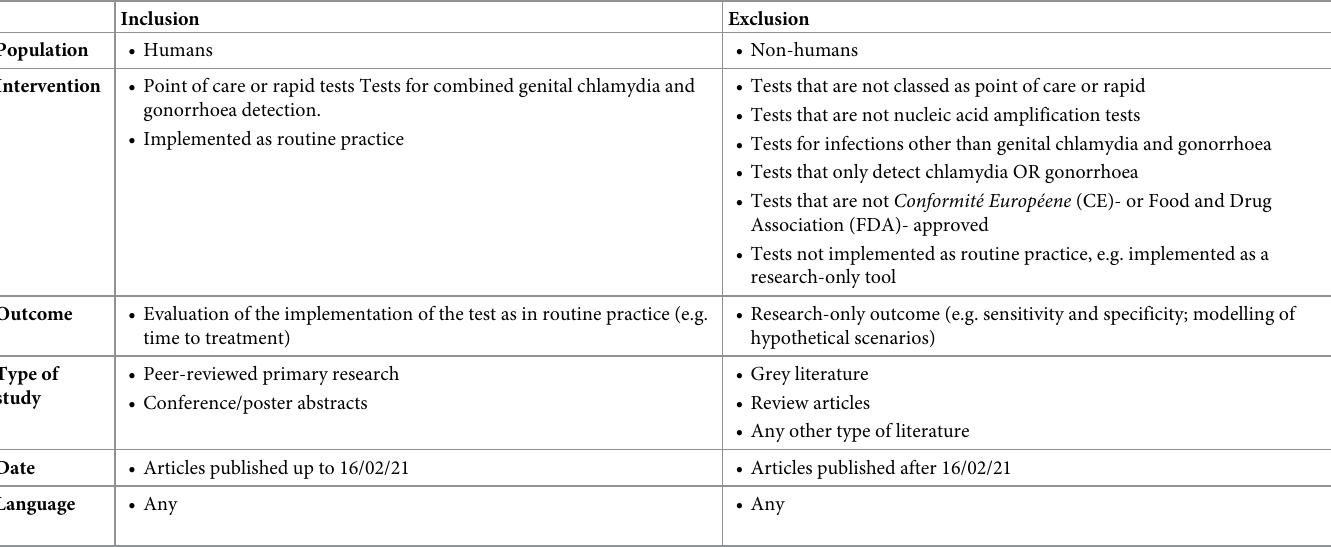
Table 1. Inclusion and exclusion criteria.